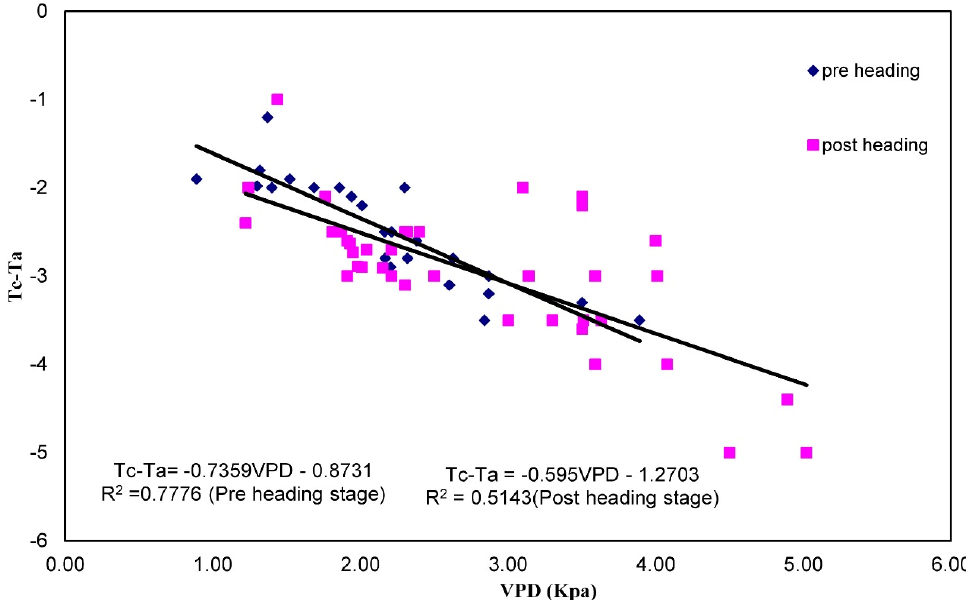
Figure 4. Lower baseline and upper limit for determination of CWSI at pre ‐ heading and post heading stages.